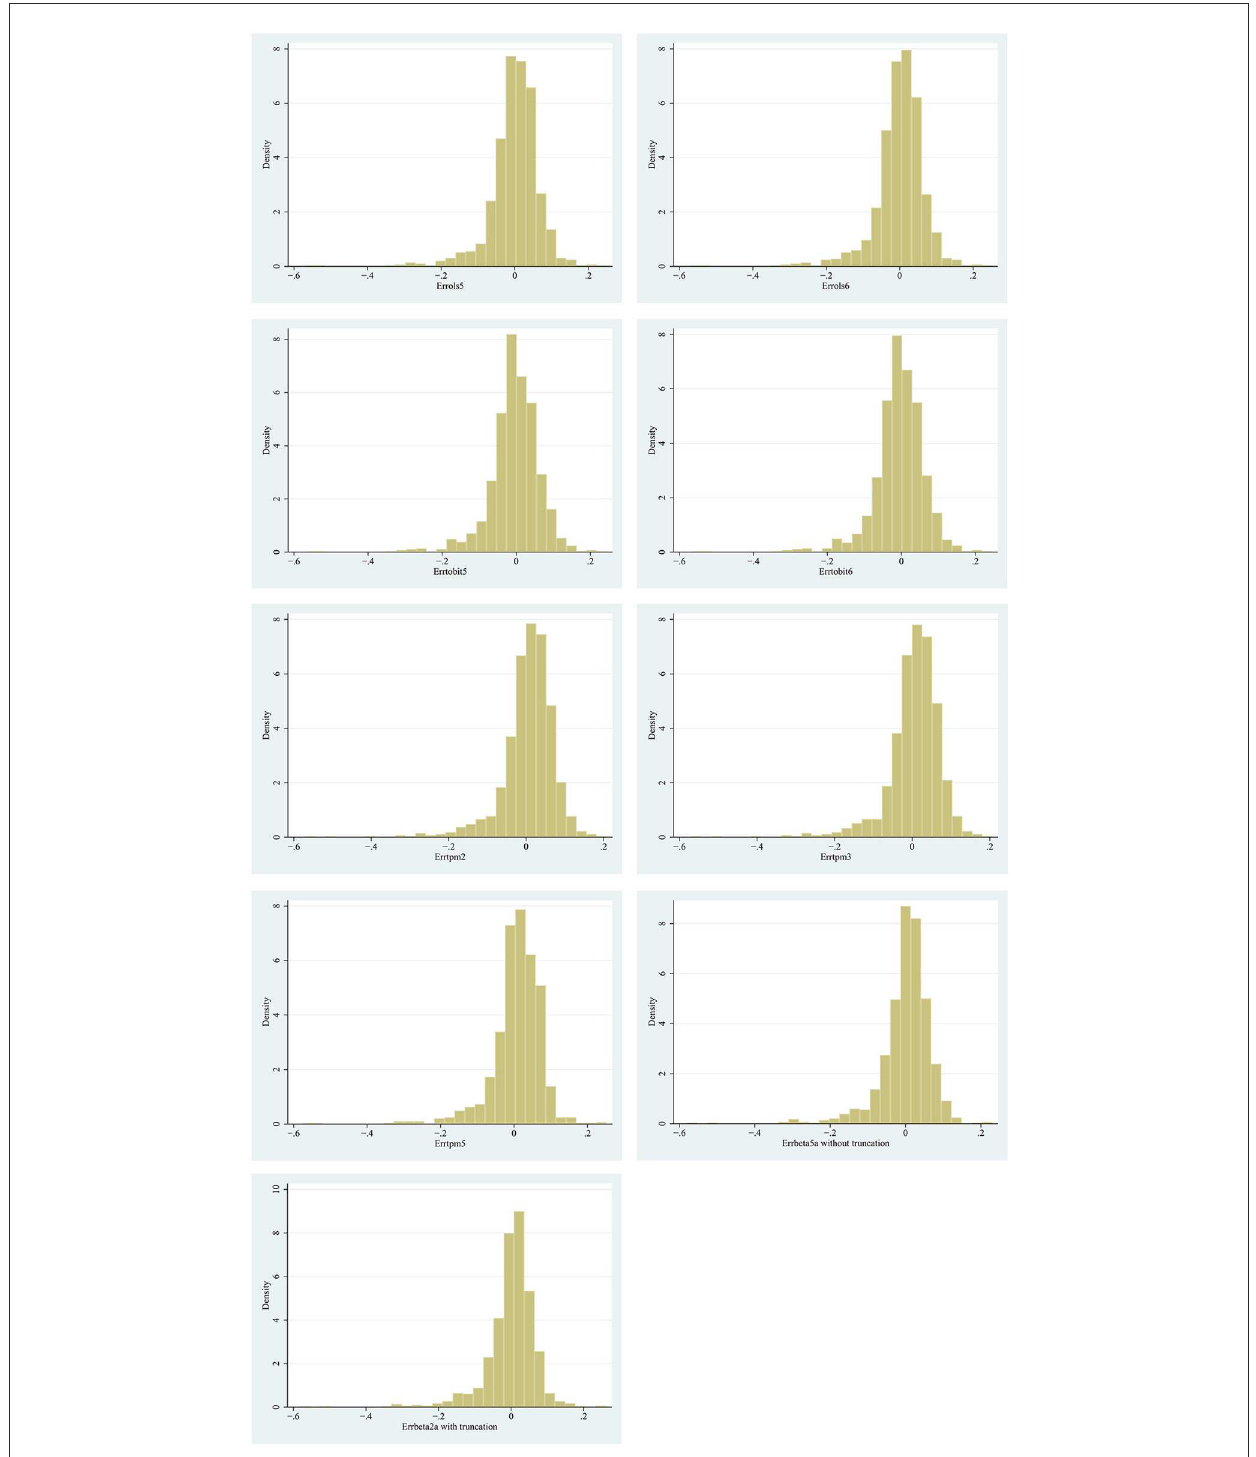
FIGURE3 Predicting the error distribution of nine models.